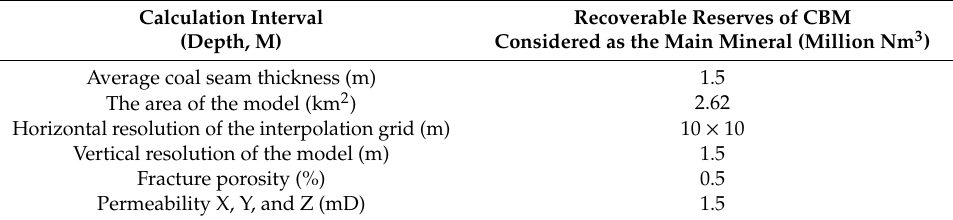
Table 3. Structural parameters of the simulation model for CBM extraction.